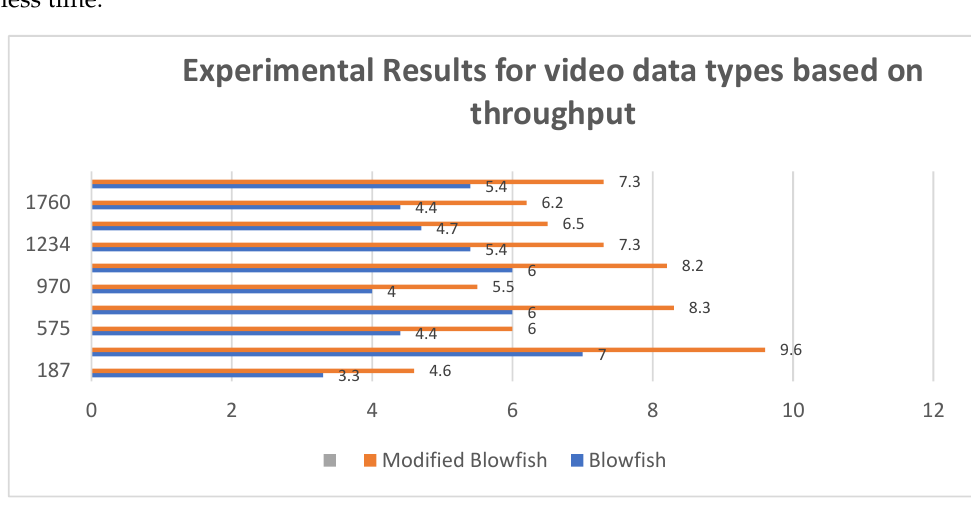
Figure 7. Comparison based on throughput.